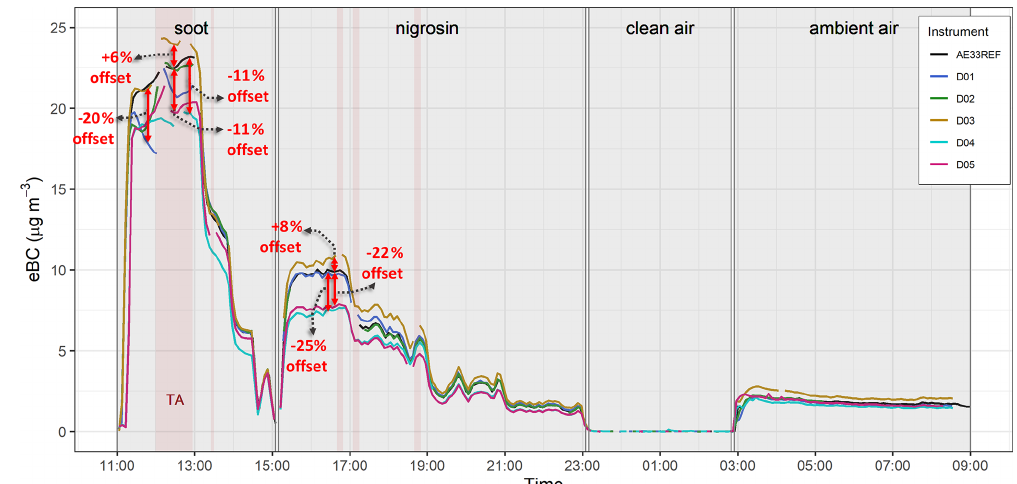
Figure 5. Time series of eBC mass concentrations at 880nm before maintenance in group D. Areas outlined in gray show the periods of clean air and aerosol supply; red bars indicate times when tape advances occurred in more than one instrument